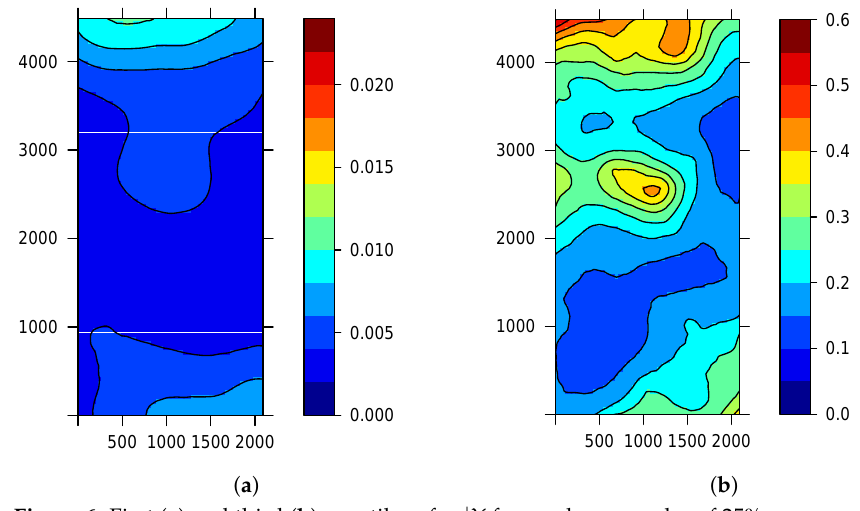
Figure 6. First ( a ) and third ( b ) quartiles of π i | Y for random samples of